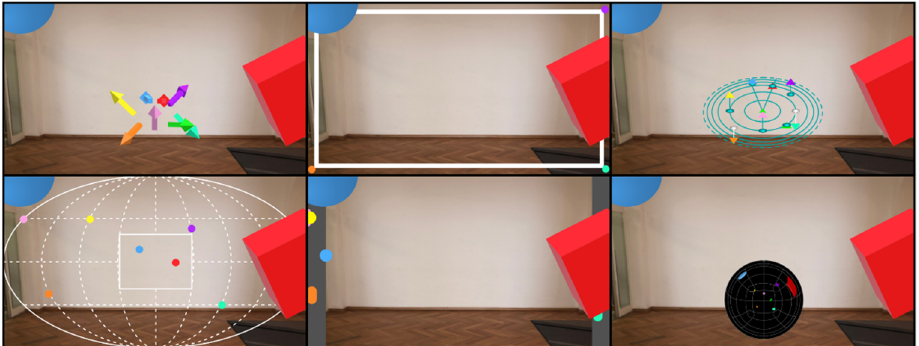
Figure 1. The 6 visual guidances compared in the work of Bork et al. Guidances 3D Arrows (top-left), AroundPlot (top-center), 3D Radar (top-right), EyeSee360 (bottom-left), sidebARs (bottom-center) and Mirror Ball (bottom-right). Reprinted with permission from ref. [2]. Copyright 2018 IEEE.